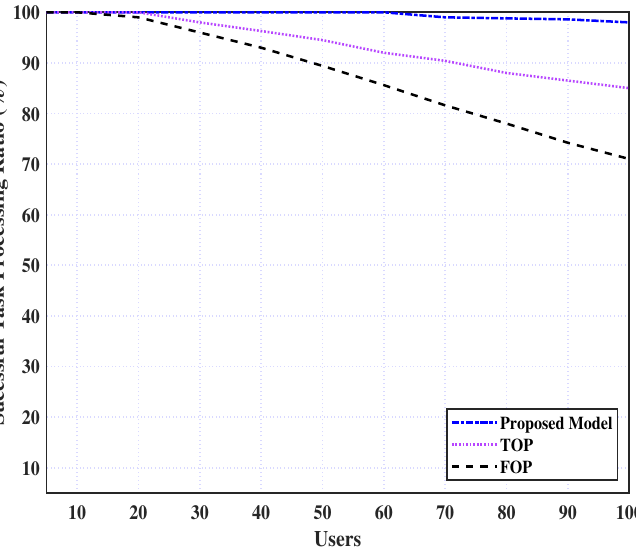
Figure 9. A comparison of successful task processing ratio under different numbers of users (K = 5, N =